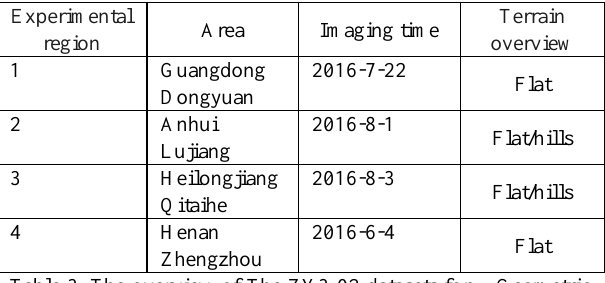
Table 3. The overview of The ZY3-02 datasets